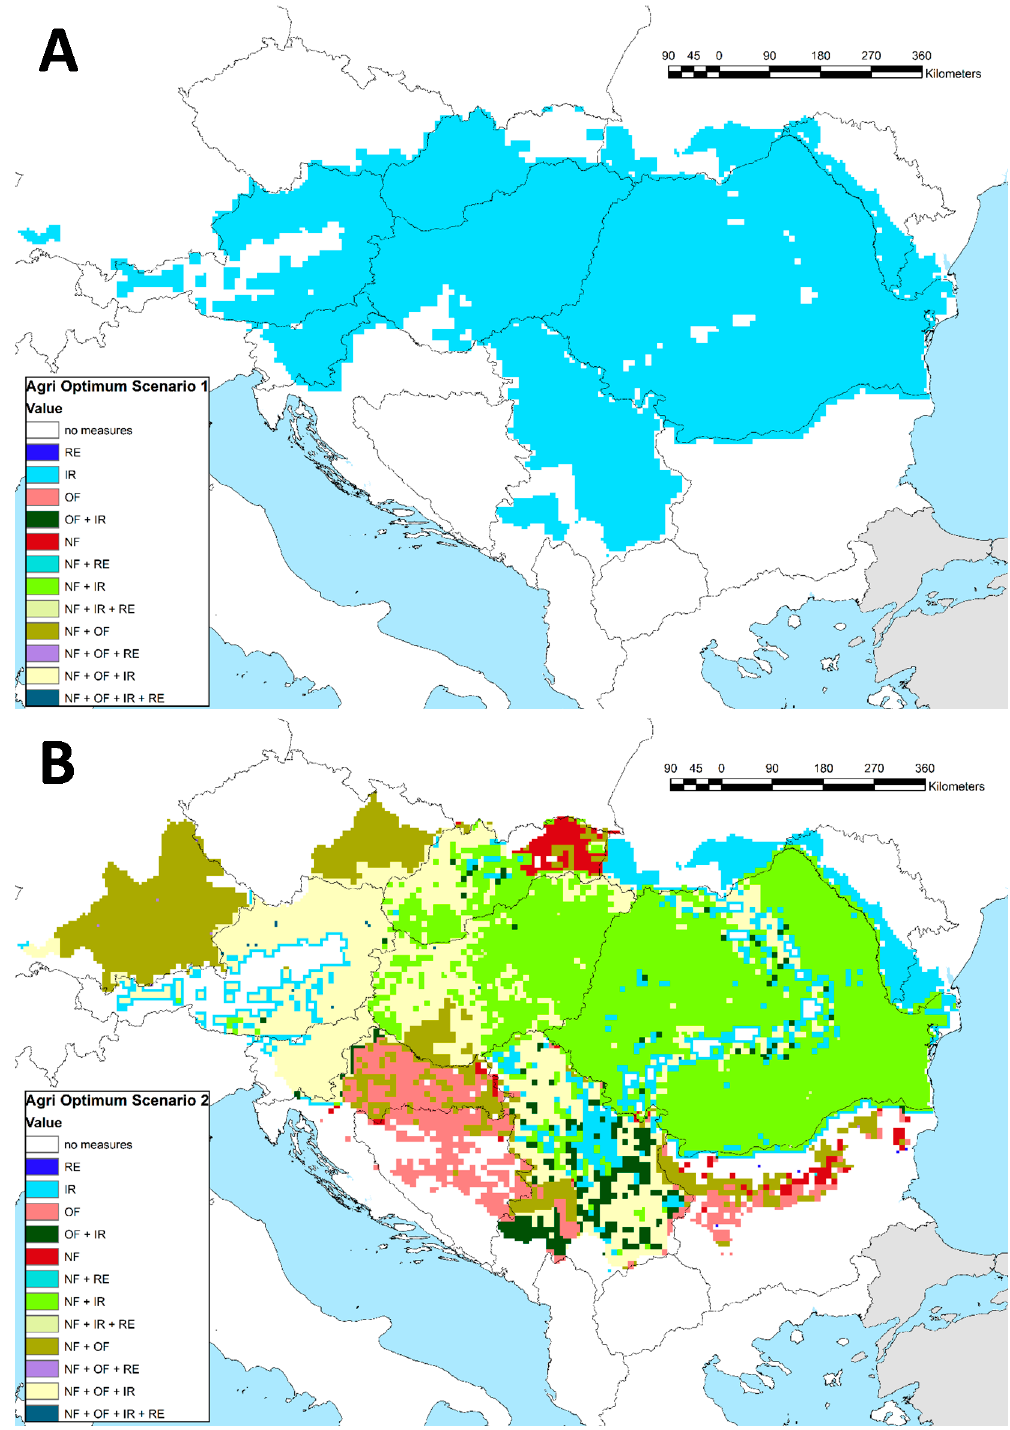
Figure 9. Spatial allocation of two Pareto efficient strategies: S1 ( A ) and S8 ( B ), for the Danube catchment (region 11), considering the agriculture related improvement measures. For each family of measures the greater the percentage of application of the measure, the greater is the map surface corresponding to it. A scenario is generated by combining individual measures maps if the implementation priority is larger than the threshold value derived in the optimization process.